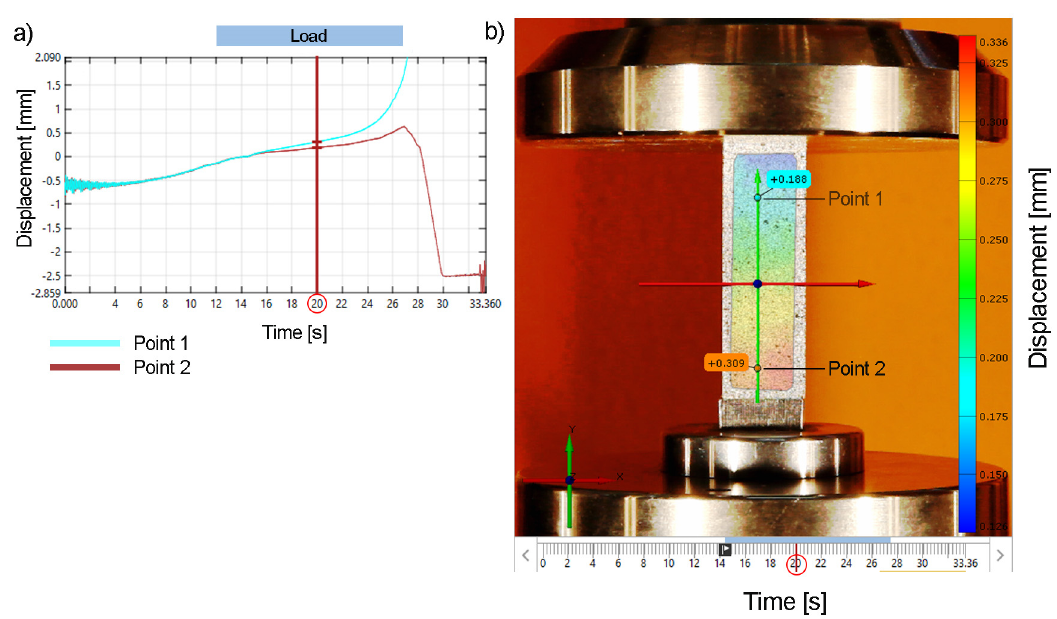
Figure 6. ( a ) Displacement / time diagram of points 1 and 2 and ( b ) displacement color map of test piece A1.